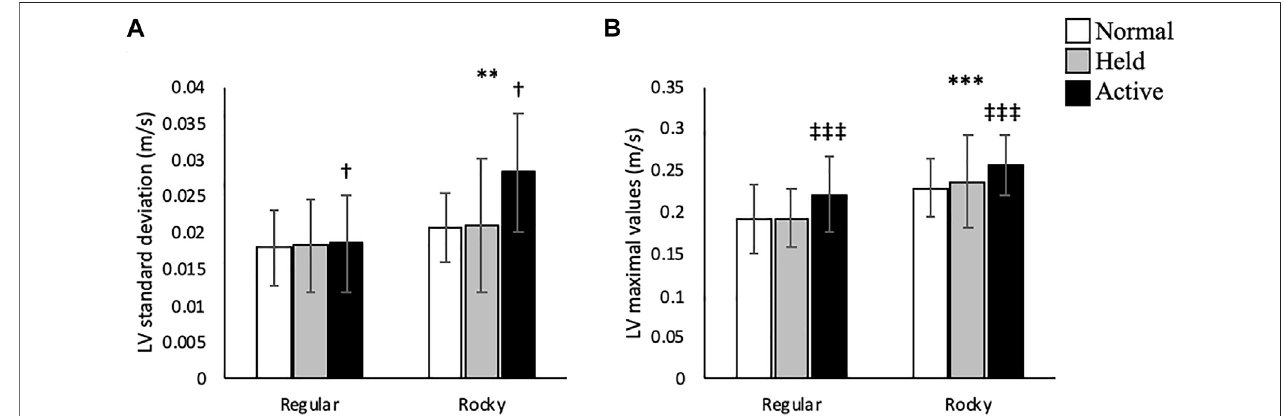
FIGURE 5 | Trunk linear velocity (A) standard deviation (m/s) and (B) maximal values (m/s) according to surface type for each arm condition in the mediolateral direction. ** and *** shows that rocky surface led to larger values than regular surface at p < 0.01 and p < 0.001, while † shows that active arm swing led to larger values than normal arm swing at p < 0.05 and ‡‡‡ shows that active arm swing led to larger values than normal and held at p < 0.001.